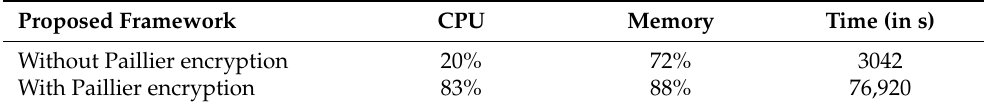
Table 1. Comparison of proposed framework with and without Paillier encryption.